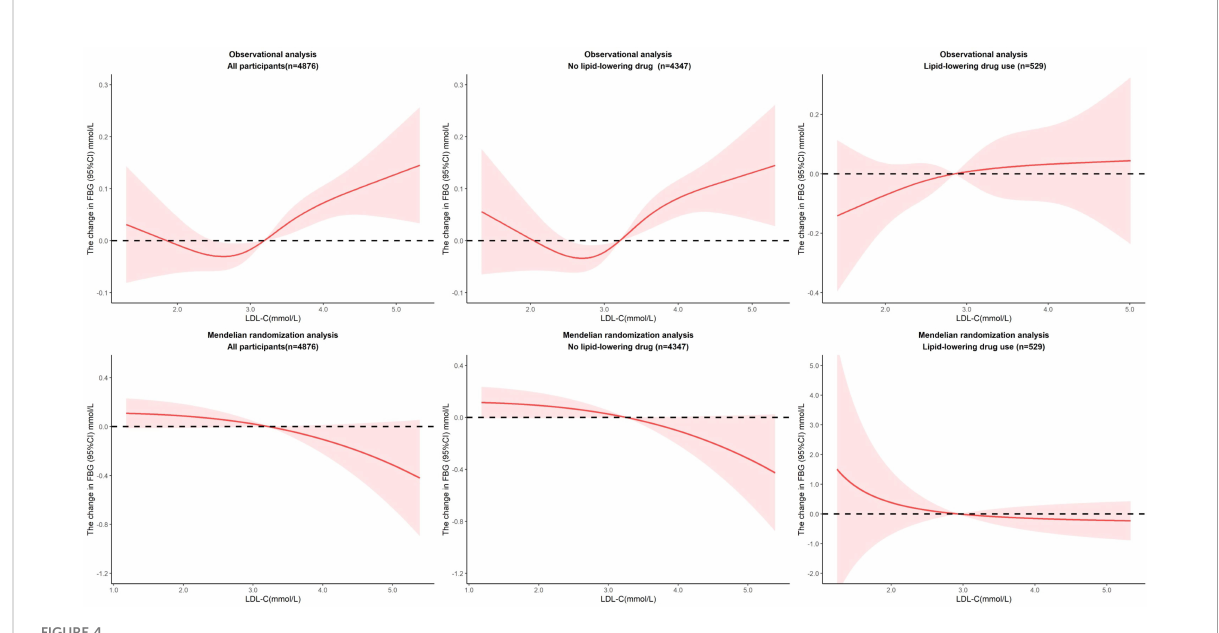
FIGURE 4 Nonlinear associations of LDL-C and FBG in observational and MR